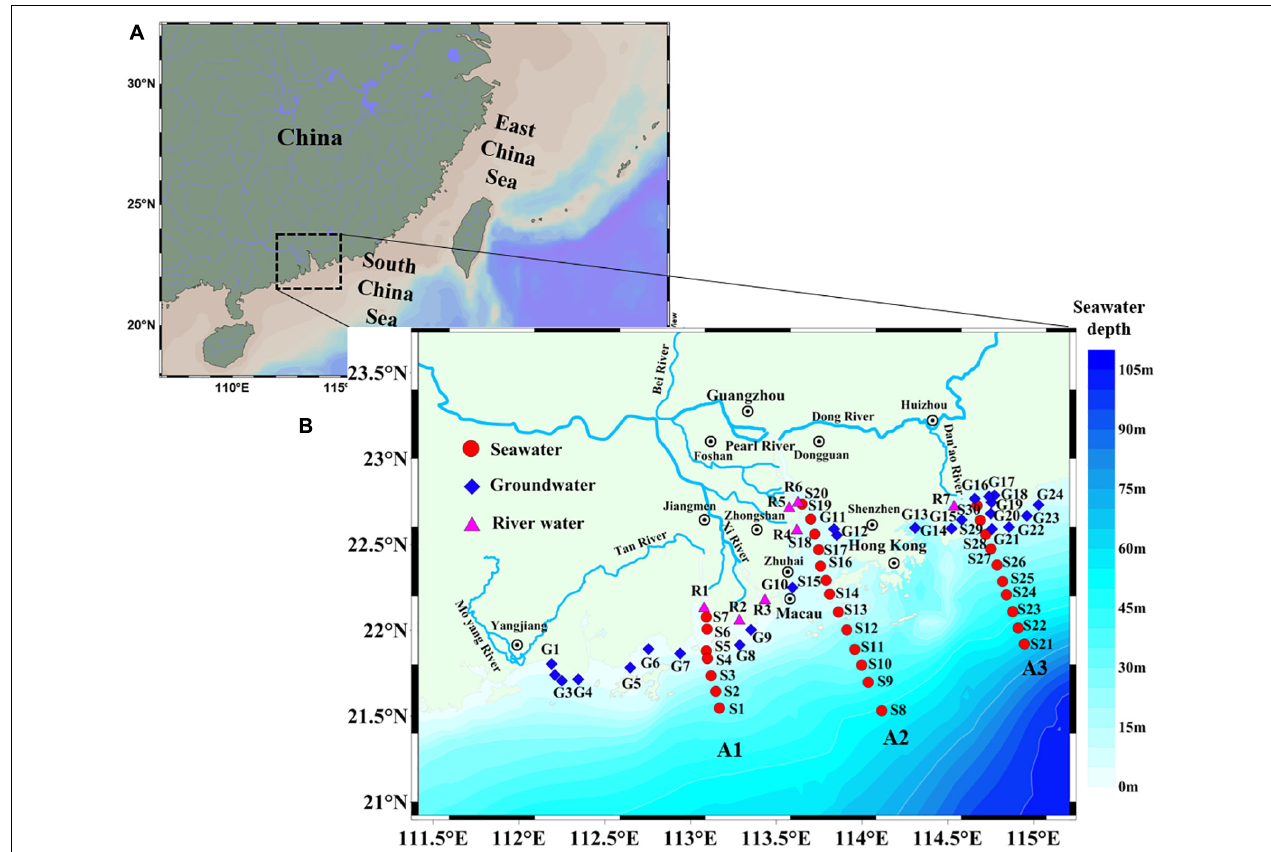
FIGURE 1 | (A) The location of the Greater Bay Area in China, and (B) the sampling sites of groundwater, river water, and seawater.